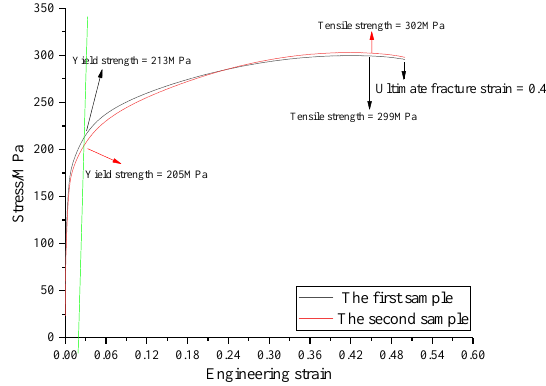
Figure 1. Stress-strain curve of test material.